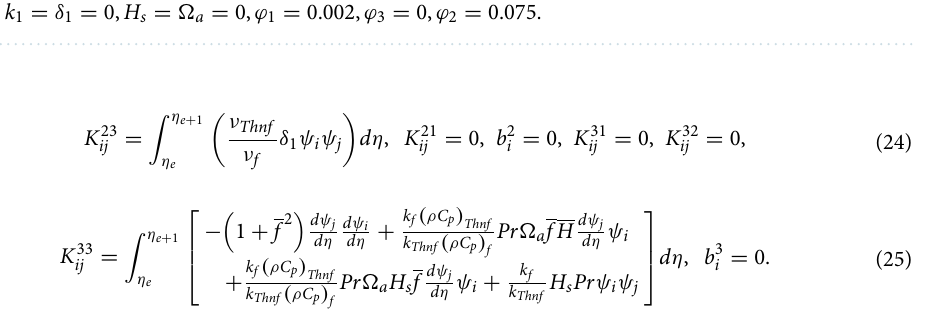
Table 3. Validation of numerical consequence for Nusselt number and skin friction coefficient when α = β = k 1 = δ 1 = 0, H s = � a = 0, ϕ 1 = 0.002, ϕ 3 = 0, ϕ 2 = 0.075.